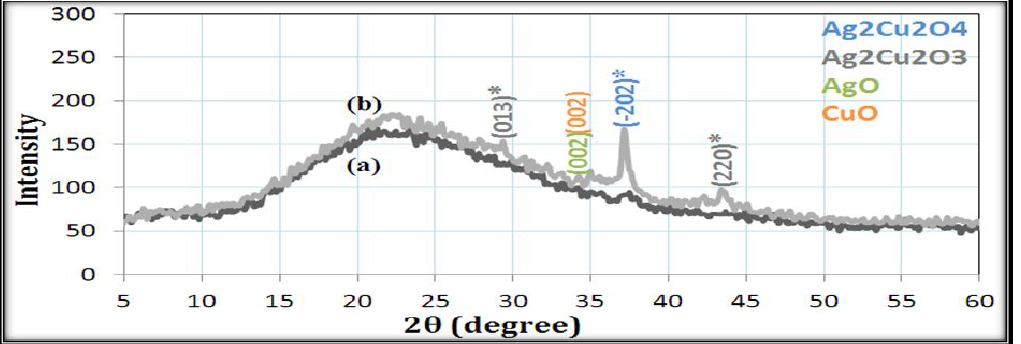
Fig.6: X-ray diffraction pattern of Ag Cu O film sintered at 300 °C (a) deposited at room 2 2 4 temperature (b) annealing at 200°C for half an hour. Table 6: Structural parameters viz. inter-planar spacing, crystallite size and Miller indices of Ag Cu O films sintered at 300°C and annealing at 200°C for half an hour. 2 2 4 2θ d d FWHM G.S hkl hkl compounds hkl phase card No. (Deg.) Exp.(Å) Std. (Deg.) (nm) 37.16 ------ Ag Cu O 2 2 4